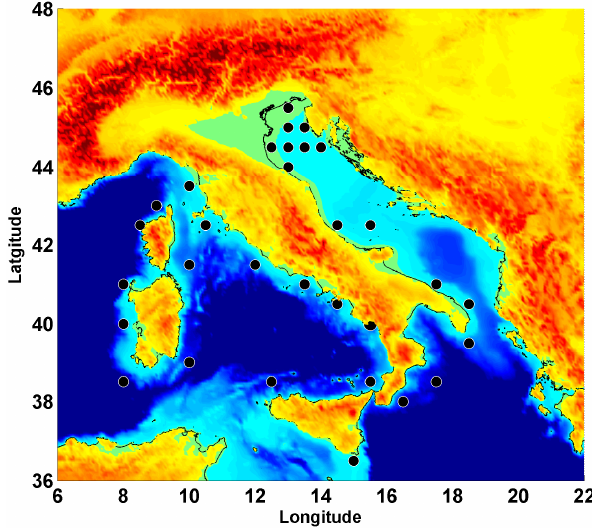
Figure 1. The position of the 27 selected WAM-grid points (0.5 ° resolution) along the Fig. 1. The position of the 27 selected WAM-grid points (0.5 ◦ reso- Italian coast. Points indicate the sites tested for the linear relation between calibrated lution) along the Italian coast. Points indicate the sites tested for the ERA-40 UNILE and ISMAR wave datasets. linear relation between calibrated ERA-40 UNILE and ISMAR wave